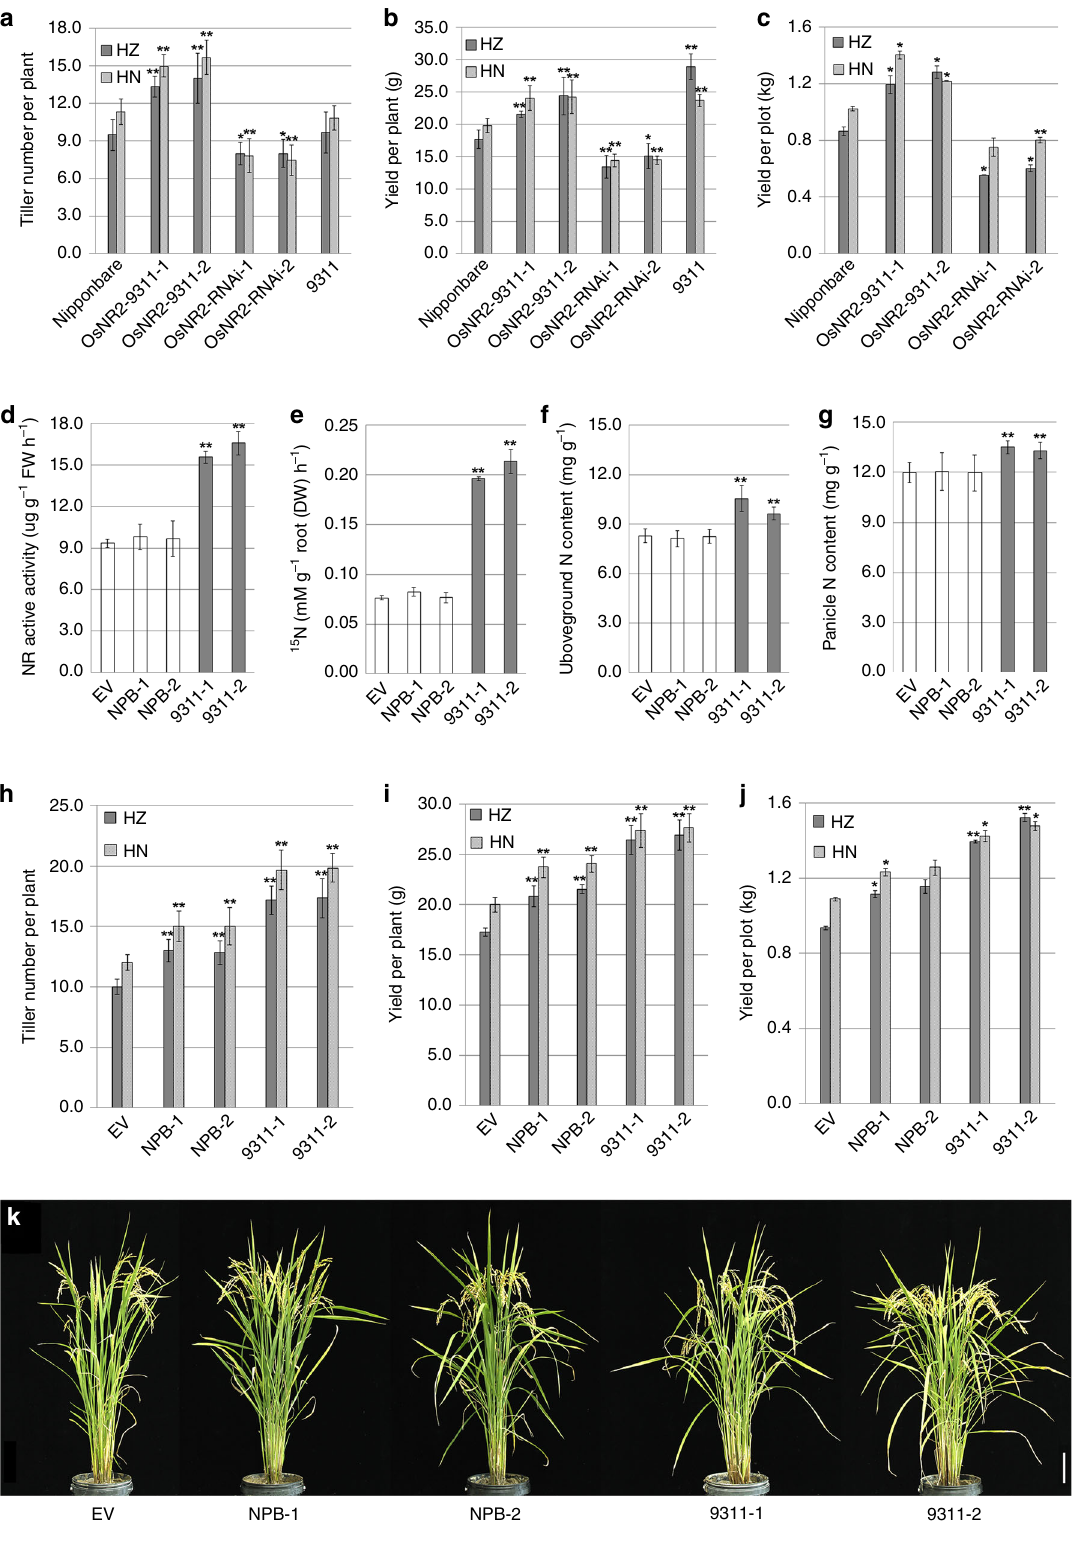
targets for breeders aiming to improve the world ’ s rice yield and the prospects for future global food